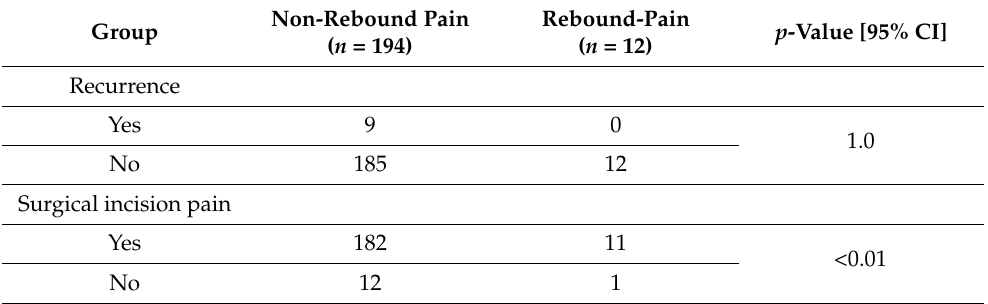
Table 4. Cont. Group